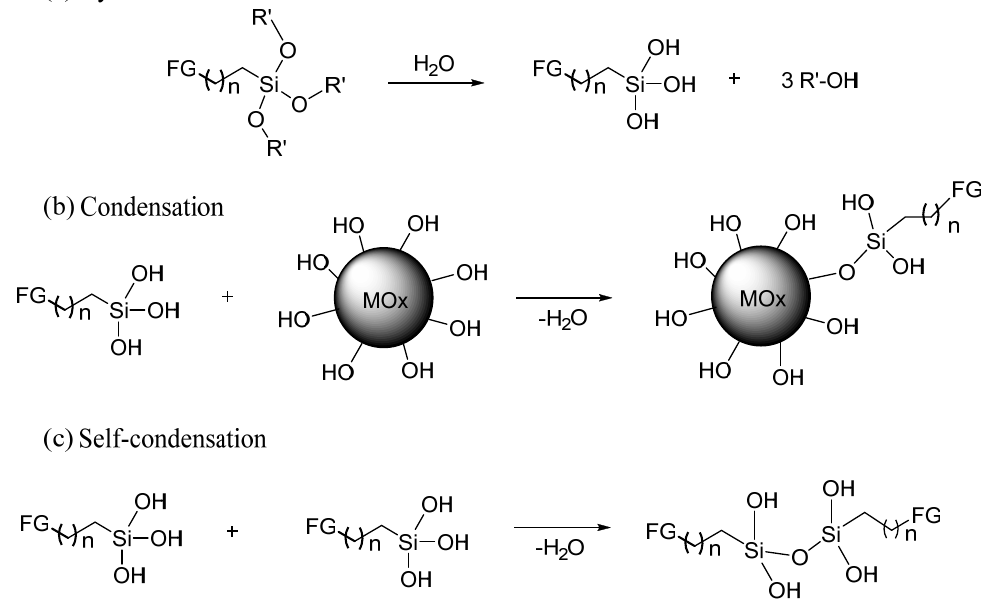
Figure 1. Scheme of the modification of metal oxide particles with an alkoxysilane derivative. ( a ) Hydrolisis; ( b ) Condensation; ( c ) Self-condensation. MOx: metal oxide, and FG: H, Hal-, NH 2 , SH, acryloxy group, between others.